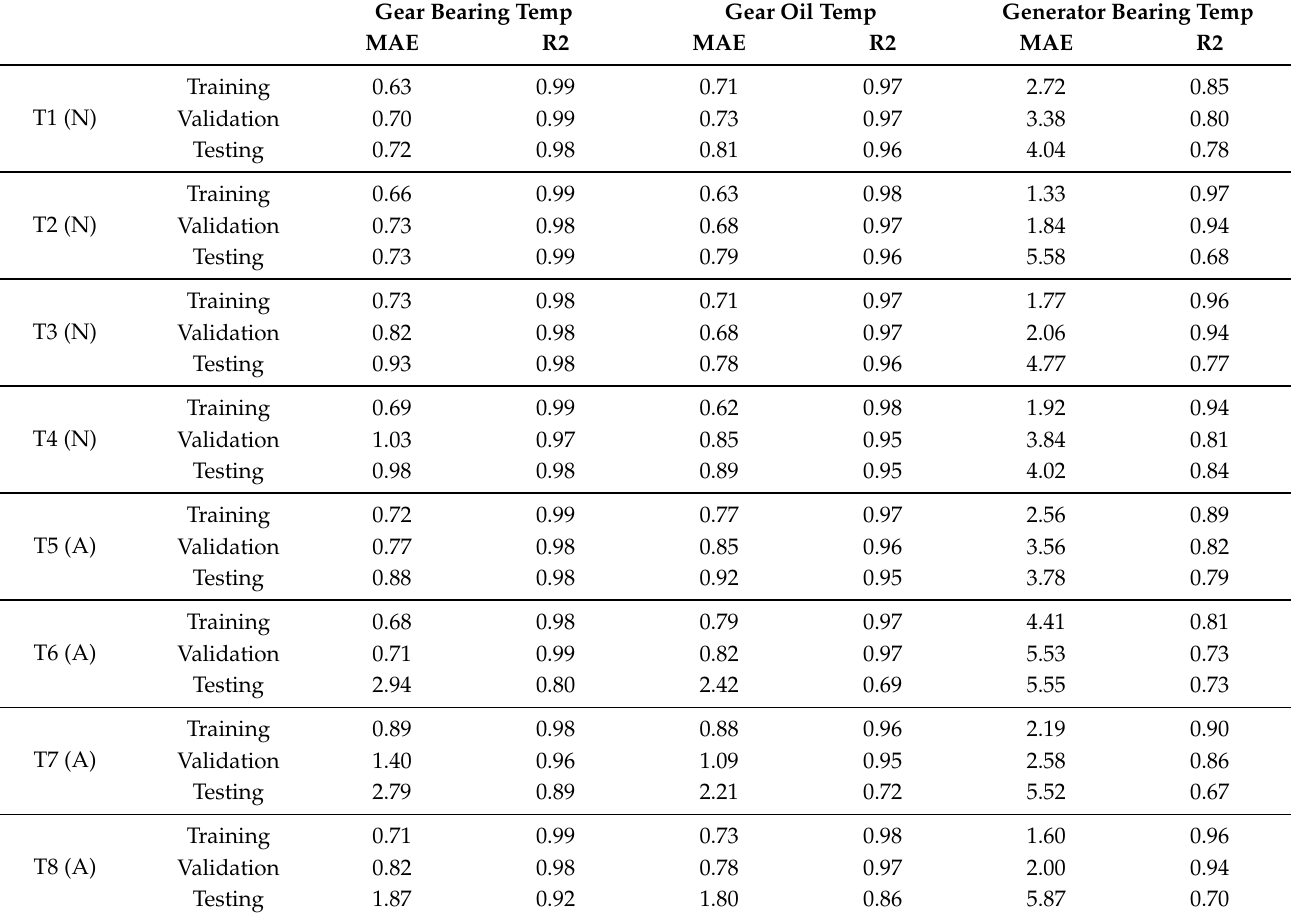
Table 4. Performance metrics of each model. (N) and (A) indicate which turbines are normal or abnormal, respectively. MAE and R2 are reported also for the training and validation periods as a sanity check to demonstrate that the training and validation are correctly